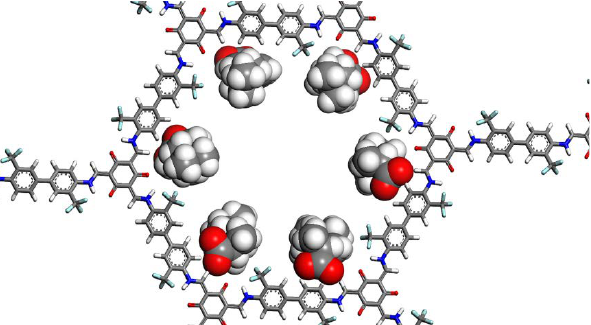
Figure 3. A view along the covalent organic framework (COF) pore axis showing the orientations of six deprotonated ibuprofen molecules.